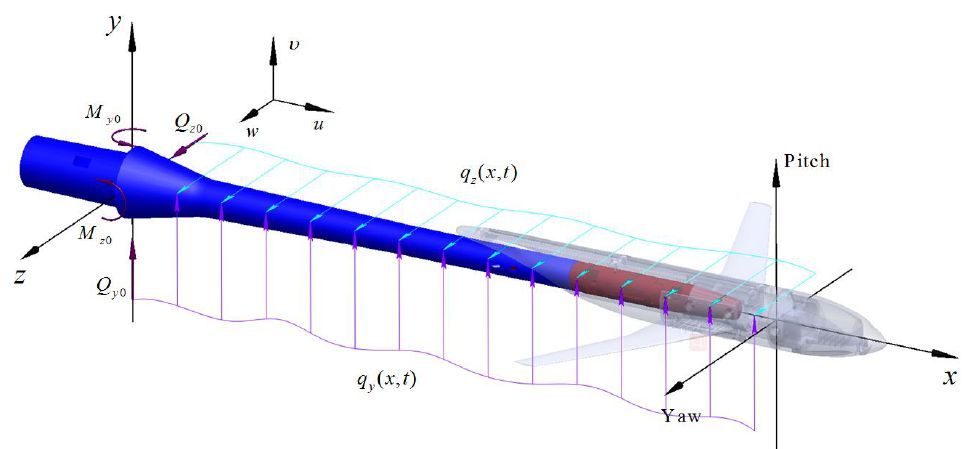
Figure 2. Long cantilever support system simplified into a Bernoulli beam.